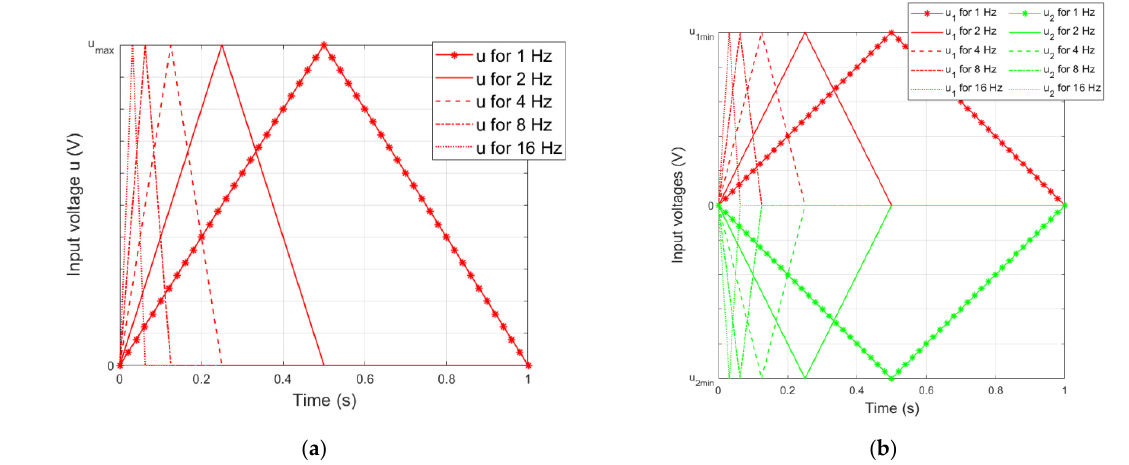
Figure 4. Courses of input voltages ( a ) in experiments 21–70 and ( b ) in experiments 71–120. Table 3. Maximum and minimum values of input voltages in laboratory experiments 21 to 40.